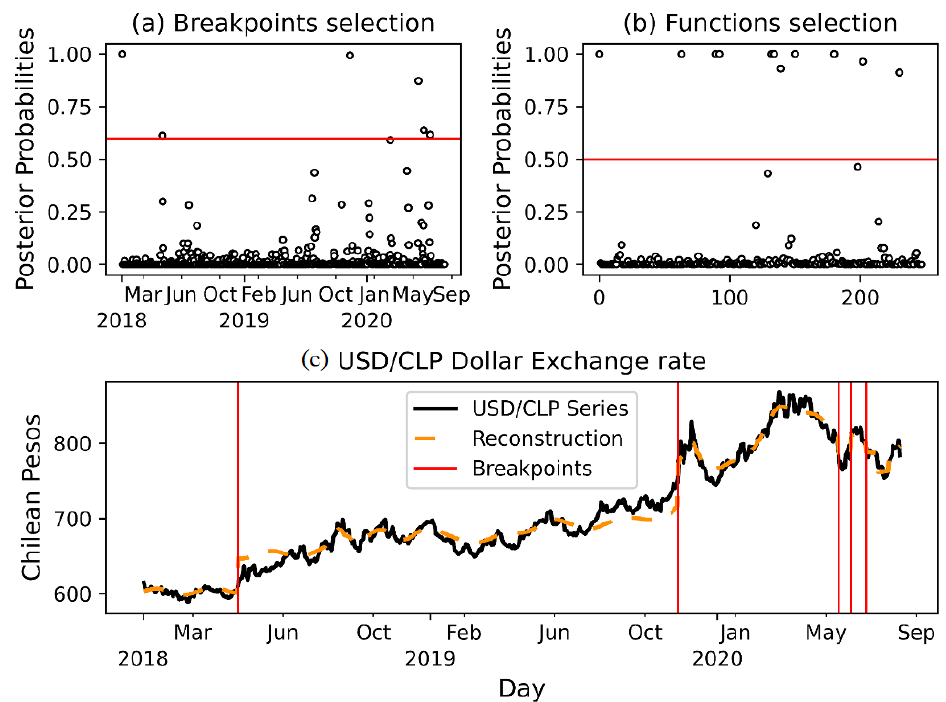
Figure 8. Top : Posterior probabilities for selection of change points ( a ) and functions ( b ) with a prior probability of 0.3 for the onset of social protests and the declaration of COVID-19 as world pandemic by the World Health Organization, for the segmentation part. Bottom : ( c ) Estimated expectation and change